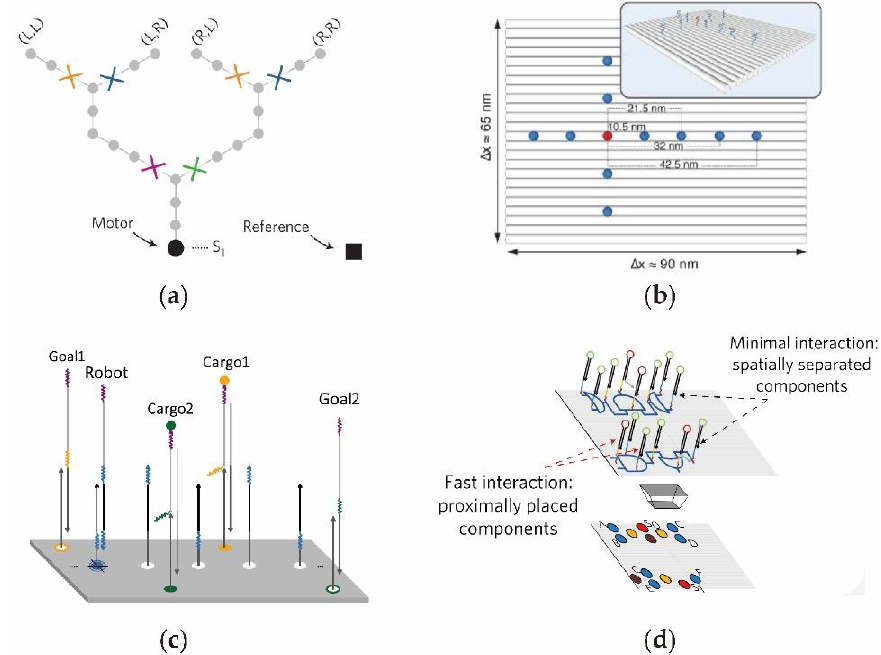
Figure 5. Design of DNA circuits on origami surface. ( a ) DNA walking motor that can follow the path on the DNA origami surface. ( b ) On-surface DNA circuit that can establish signal transmissions with addressable positions. ( c ) DNA transport cargos on origami surface. ( d ) On-surface DNA logic gates.